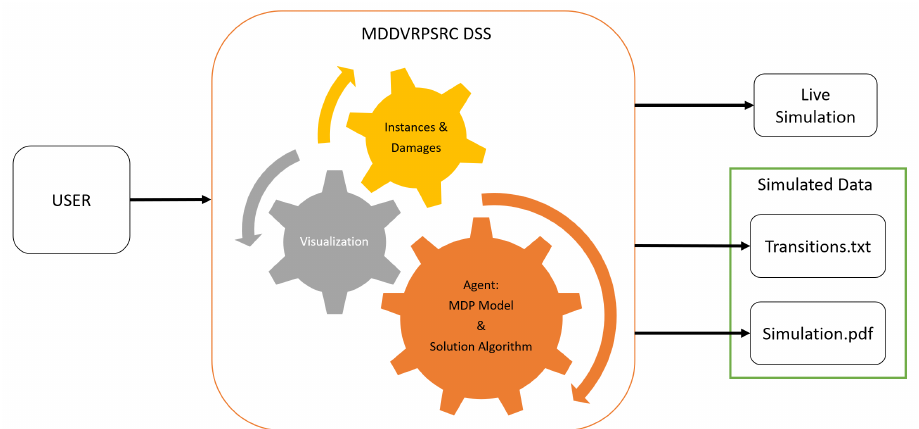
Figure 6. MDDVRPSRC DSS for medical delivery